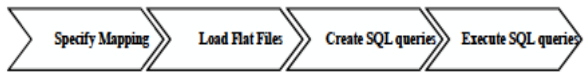
Fig. 2. Valery process.